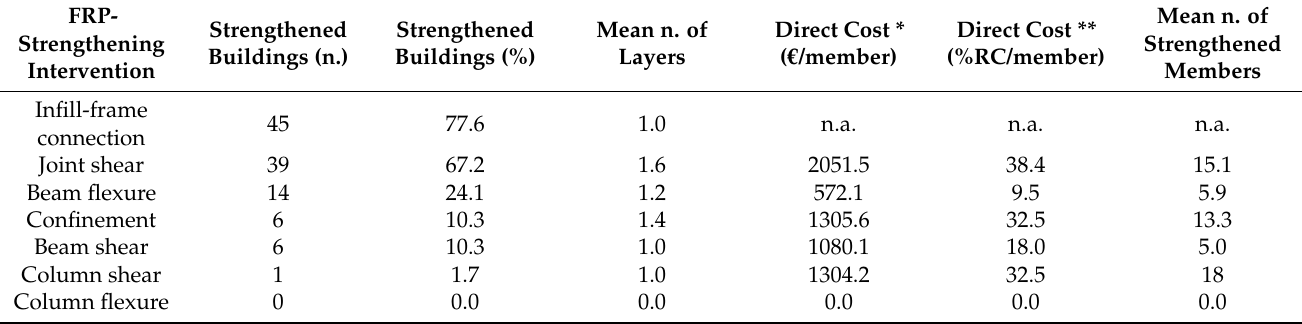
Figure 6. FRP-strengthening interventions adopted in a local-strengthening strategy ( a , b ). Table 1. Cost of FRP-strengthening interventions in a local-strengthening strategy (58